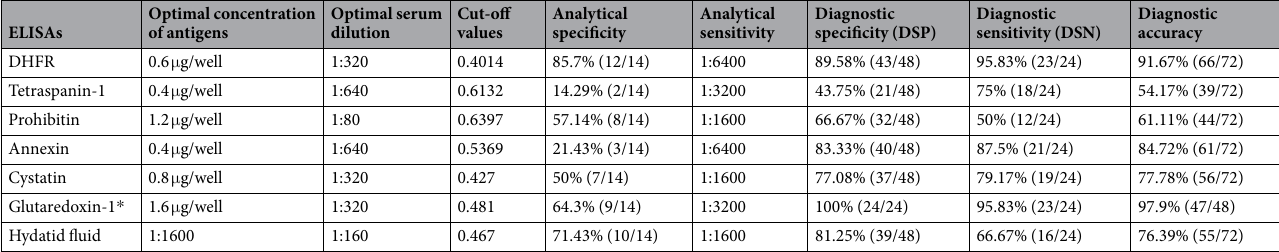
Table 2. Comparative evaluation of the serological assays for diagnosis of CE in sheep. * Our previous published data, ref.